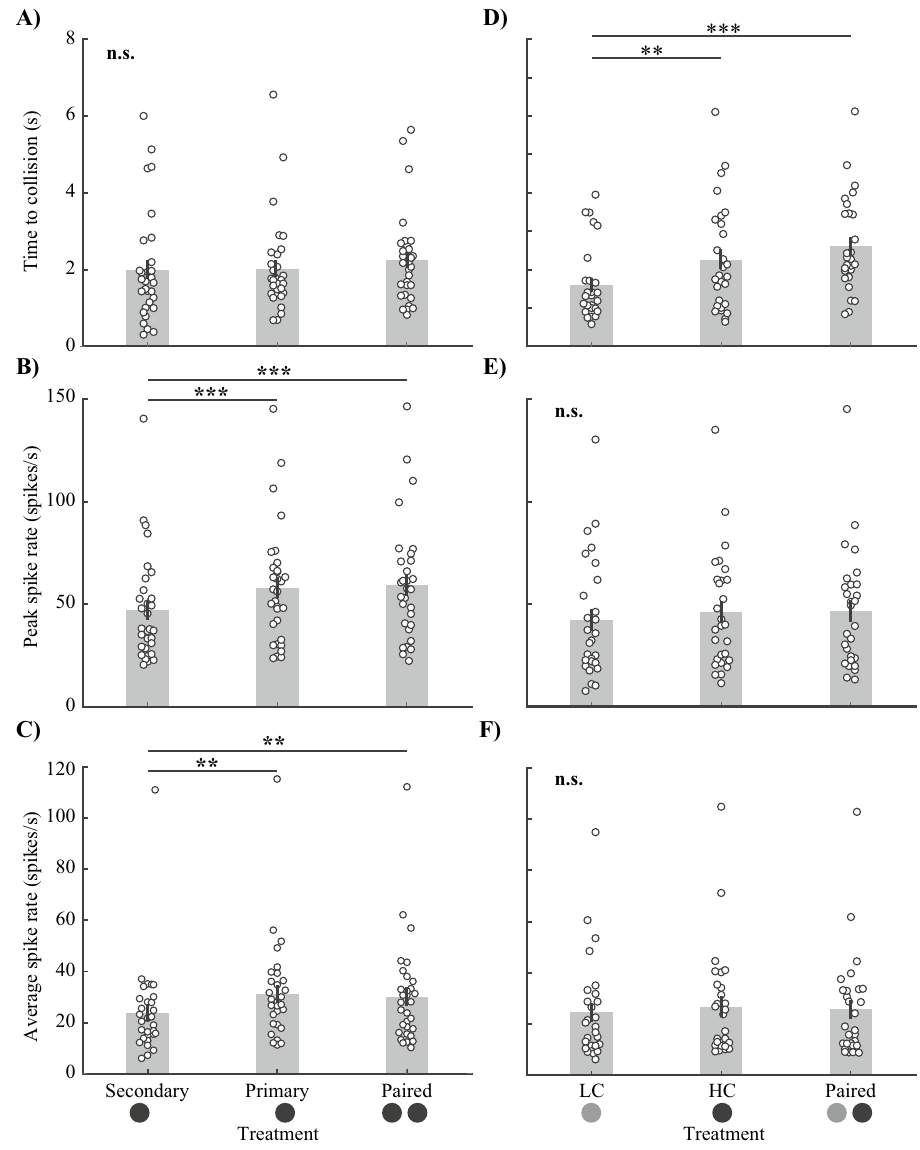
Figure 6. The firing parameters of MLG1 neurons in response to single and paired looming stimuli. ( A – C ) Experiment 1, stimuli of equal contrast; ( D – F ) Experiment 2, stimuli of different contrasts. When all stimuli were of equal contrast, there were no differences between ( A ) the time of the response regardless of the number of stimuli approached. ( B ) The peak spike rate and ( C ) the average spike rate were significantly lower for the single Secondary stimulus when compared with either the single Primary stimulus or Paired stimuli. However, the responses to Paired stimuli did not differ from those to the single Primary stimulus. When the stimuli differed in contrast, MLG1 neurons responded ( D ) significantly earlier to single high contrast (HC) or Paired stimuli compared to the single low contrast (LC) stimulus. However, the time of response was not significantly different between the single HC stimulus and the Paired stimuli. No differences were found for ( E ) peak spike rate or ( F ) average spike rate between any of the treatments. All bars represent means (± SE); white circles show individual measurements. The solid black line and asterisk symbols connect levels of treatments that were found to be significantly different through pair-wise testing (*0.01 < p < 0.05, **p < 0.01, ***p < 0.001, n.s. = not significant). All statistical tests were performed on transformed data but were back transformed for